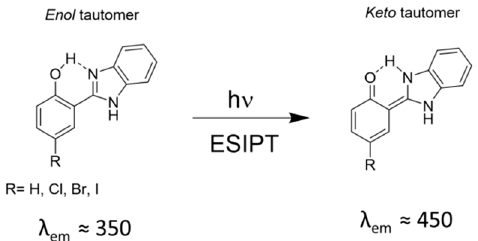
Figure 4. ESIPT fluorescence of benzimidazol derivatives.